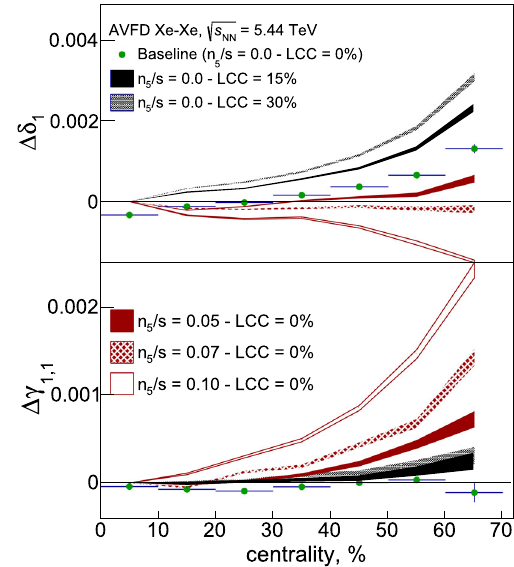
Fig. 4 The centrality dependence of (cid:9)δ 1 (upper panel) and (cid:9)γ 1 , 1 (lower panel), the charge dependent difference of δ 1 and γ 1 , 1 between opposite- and same-sign pairs, in Xe–Xe collisions at 5 . 44 TeV. The results from the analysis of the baseline sample are represented by the green markers. The various bands show the AVFD expectations for (cid:9)δ 1 and (cid:9)γ 1 , 1 for various values of n 5 / s (red bands) and percentage of LCC (blue bands)